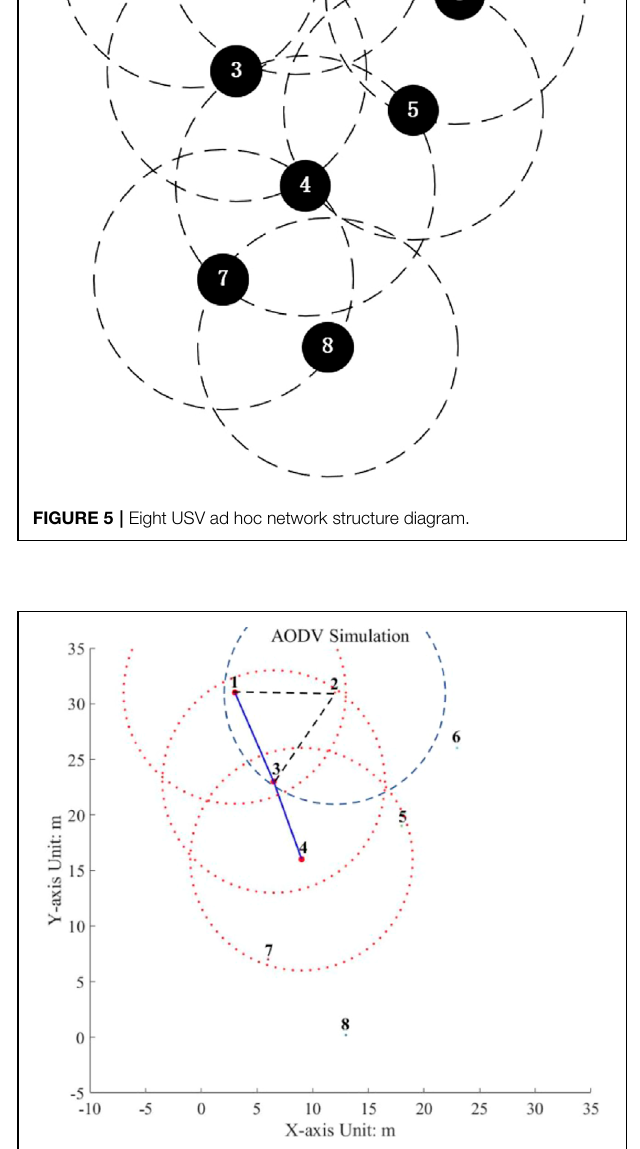
FIGURE 6 | Routing simulation diagram from node 1 to node